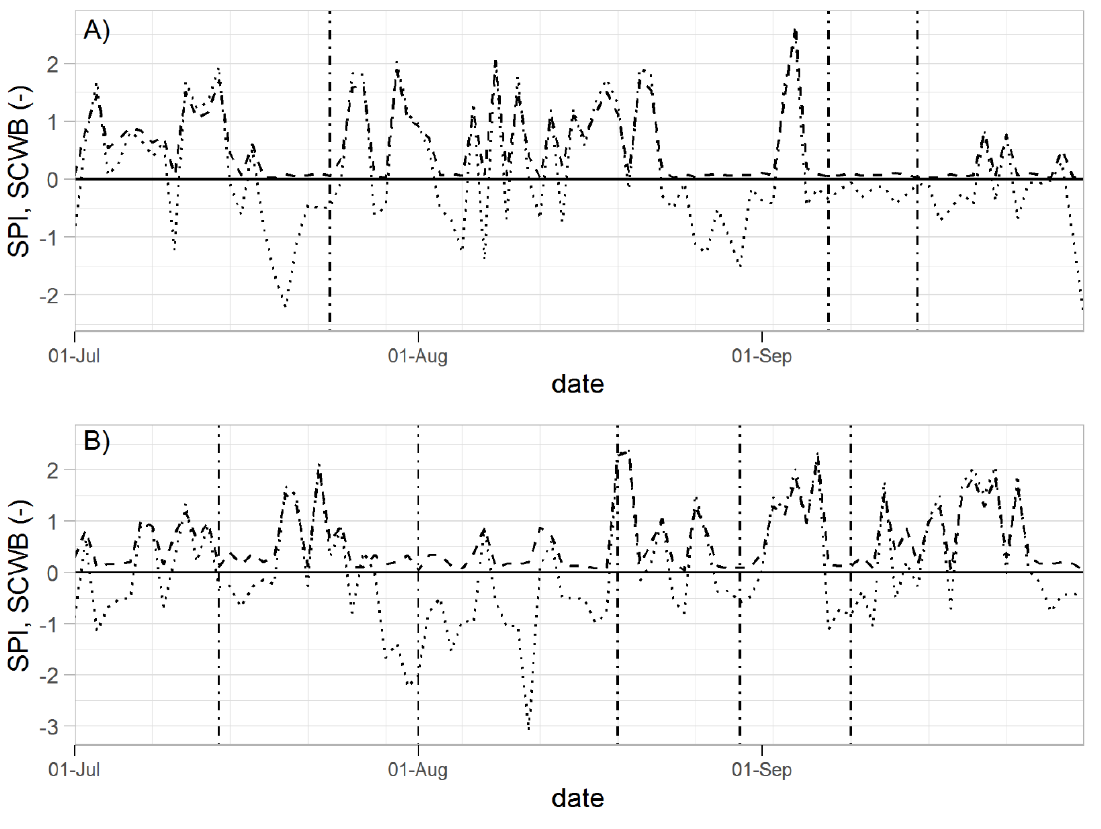
Figure 7. Drought indices: SPI (dashed lines) and SCWB (dotted lines) for ( A ) the Biebrza National Park in 2016 and ( B ) the Janów Forest Landscape Park in 2017. Vertical dash-dotted black lines indicate UAS flight campaigns (Table 1).